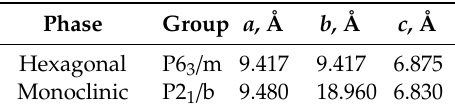
Table 2. Unit cell parameters a, b, and c (Å) (from